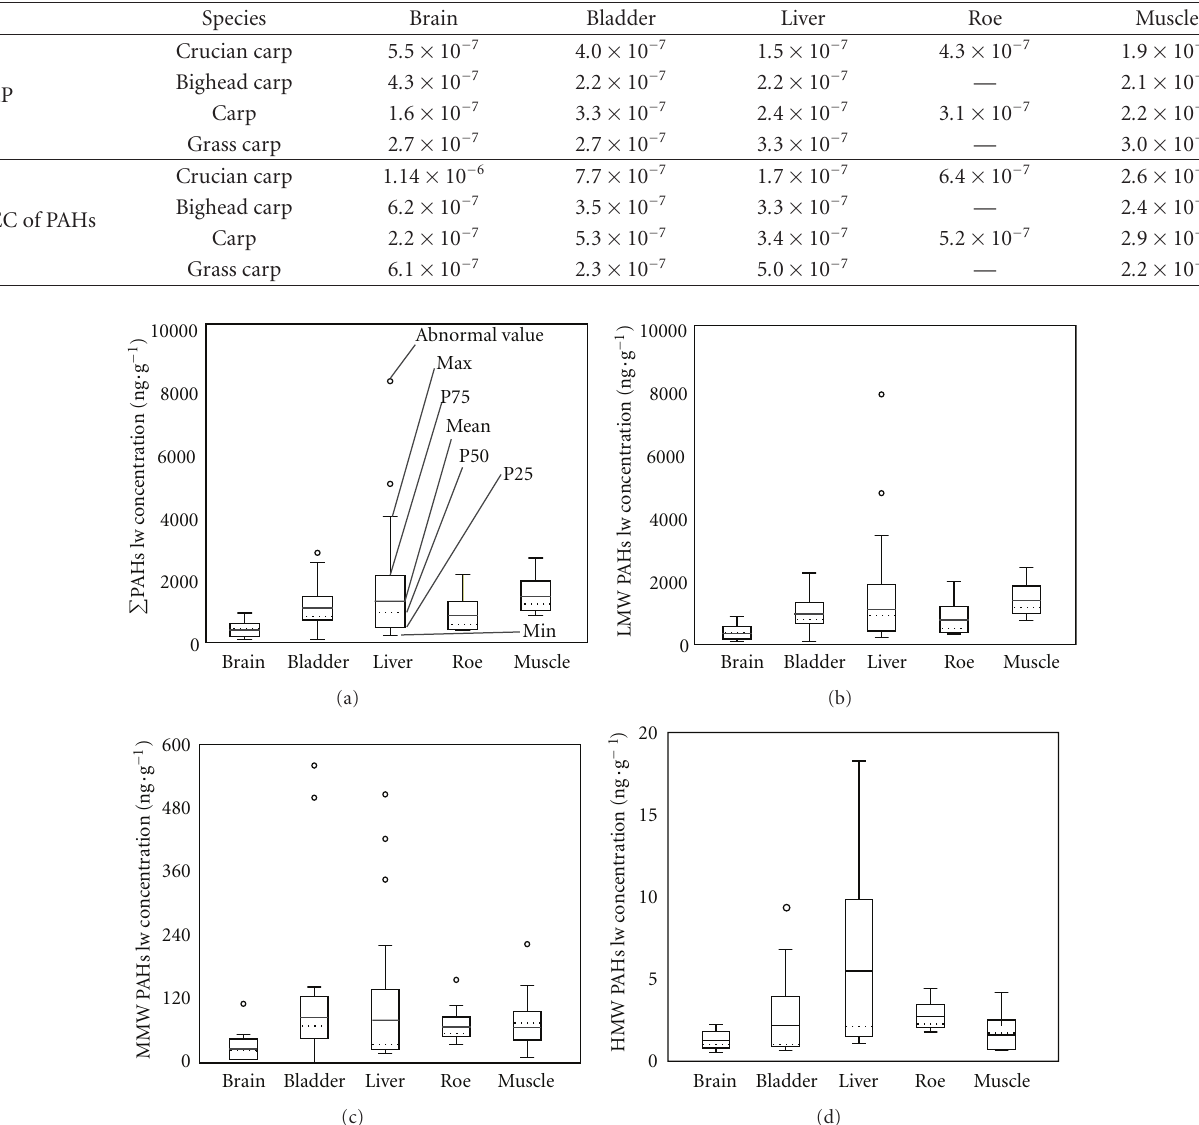
Table 8: Risk assessment on BaP and potency equivalent concentration of PAHs for human consumption of fish.